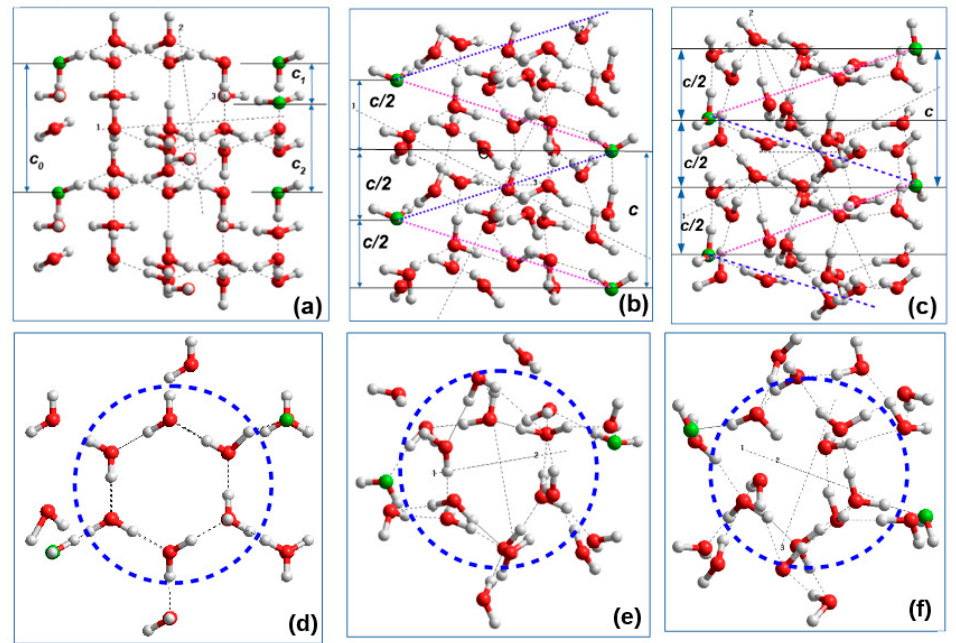
Figure 7. Extracted 42 H 2 O water clusters in Y-projection ( a,b,c ) and Z-projection ( d,e,f ): ( a ) and ( d ) for initial water cluster based on Ih structure; ( b ) and ( e ) after optimization within the D-FF PNT; ( c ) and ( f ) after optimization within the L-FF PNT. Dashed lines (with two colors: red and blue) on ( b ) and ( c ) show different direction of the helix-like structure water/ice cluster formation inside the D-FF PNT and L-FF PNT cavity cases. Dashed circles on ( d ), ( e ), and ( f ) show difference between inner and outer water/ice molecules groups. Parameters of periodical water/ice clusters structures are ( a ) c 0 = 5.434 Å, c 1 = 1.670 Å, c 2 = 3.764 Å; ( b ) c = 5.441 Å; ( c ) c = 5.456 Å—these both correspond to the unit cell parameter c in D-FF and L-FF.